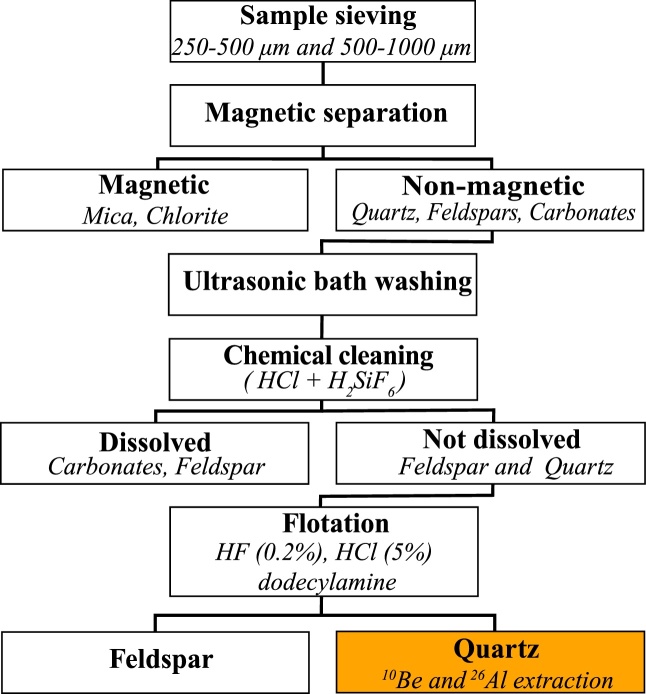
Flow diagram showing the stepwise procedure for separation quartz from river-sand samples.